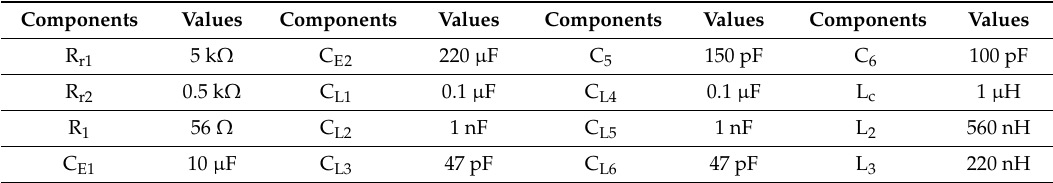
Table 1. Component values for class-C power